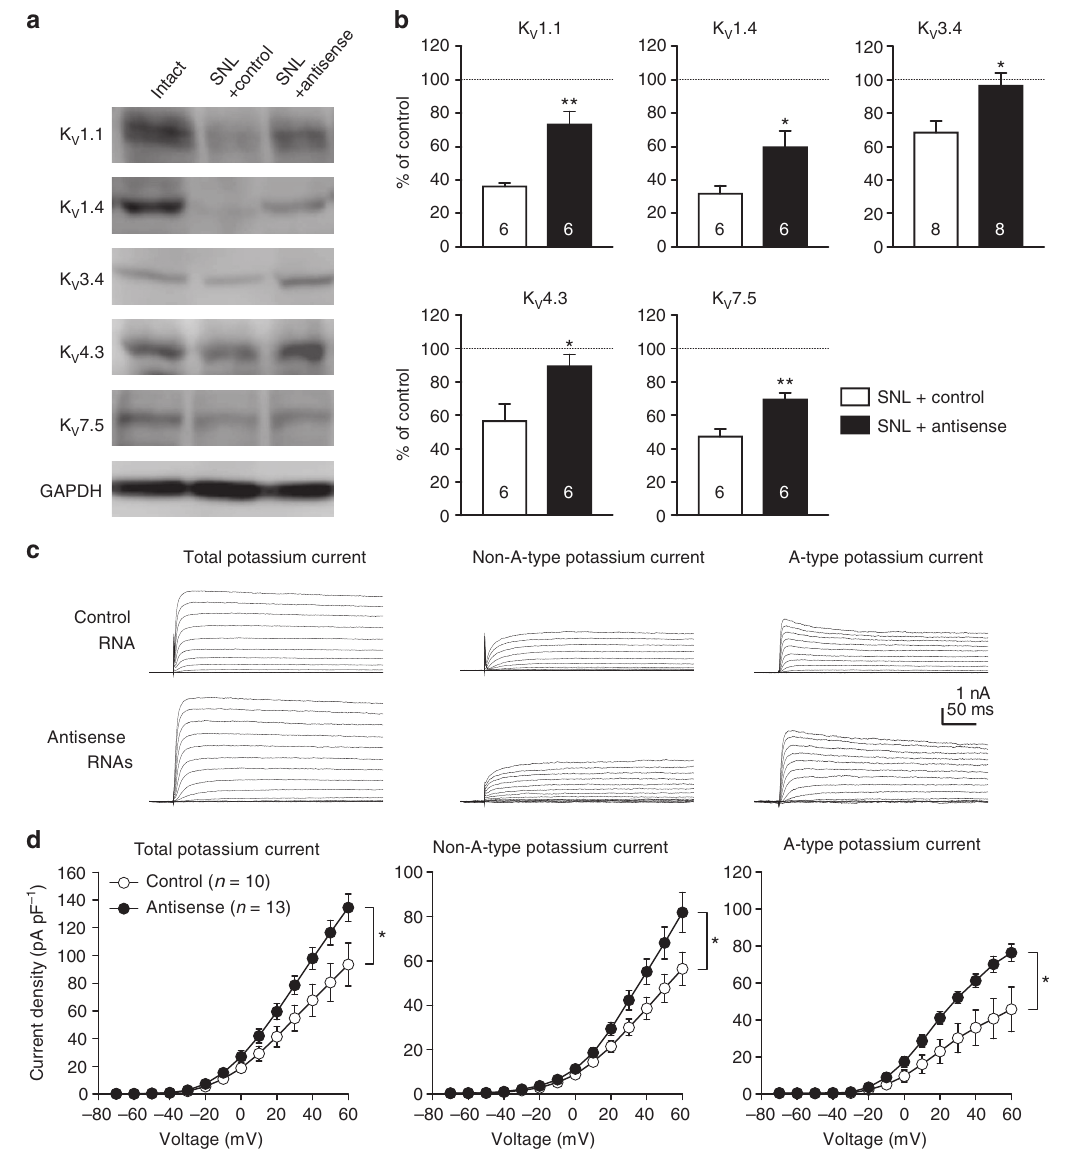
Figure 7 | miR-17-92 inhibition rescues potassium channel expressions and potassium currents in DRG neurons in the neuropathic pain state. ( a ) Representative images of immunoblotting for voltage-gated potassium channel a subunits in the L5 DRG obtained from SNL rats at day 28. Full blots can be found in the Supplementary Fig. 12. AAV vectors expressing either a control AAV vector or mixture of AAV vectors encoding TuD antisense RNAs against miR-18a, miR-19a, miR-19b and miR-92a were administered 7 days after SNL. GAPDH was used as a loading standard. ( b ) Expression levels of voltage-gated potassium channel protein, as a percentage of expression level in intact L5 DRG. Numbers of samples are indicated at the base of each bar. * P o 0.05 and ** P o 0.01 ( P ¼ 0.004 for K V 1.1; P ¼ 0.038 for K V 1.4; P ¼ 0.015 for K V 3.4; P ¼ 0.028 for K V 4.3; P ¼ 0.003 for K V 7.5), Welch’s test. ( c , d ) Potassium currents were recorded in acutely-dissociated DRG neurons 7 days after SNL. Control AAV vector or AAV vector mixture was injected 7 days before SNL. Only EGFP-fluorescent DRG neurons were recorded. ( c ) Representative traces of total, non-A-type and A-type potassium currents elicited by stepwise depolarization from (cid:2) 70 to 60mV at a holding potential of (cid:2) 80mV in small DRG neurons. ( d ) Current density of each potassium current component plotted against voltage in small DRG neurons obtained from three rats. Error bars are s.e.m. * P o 0.05 ( P ¼ 0.045 for total current; P ¼ 0.046 for non-A-type current; P ¼ 0.015 for A-type current), two-way repeated-measures subunits in DRG neurons. Expression of these subunits detected using RT-PCR, immunohistochemistry or microarray analysis were substantially decreased in DRG neurons after nerve injury.